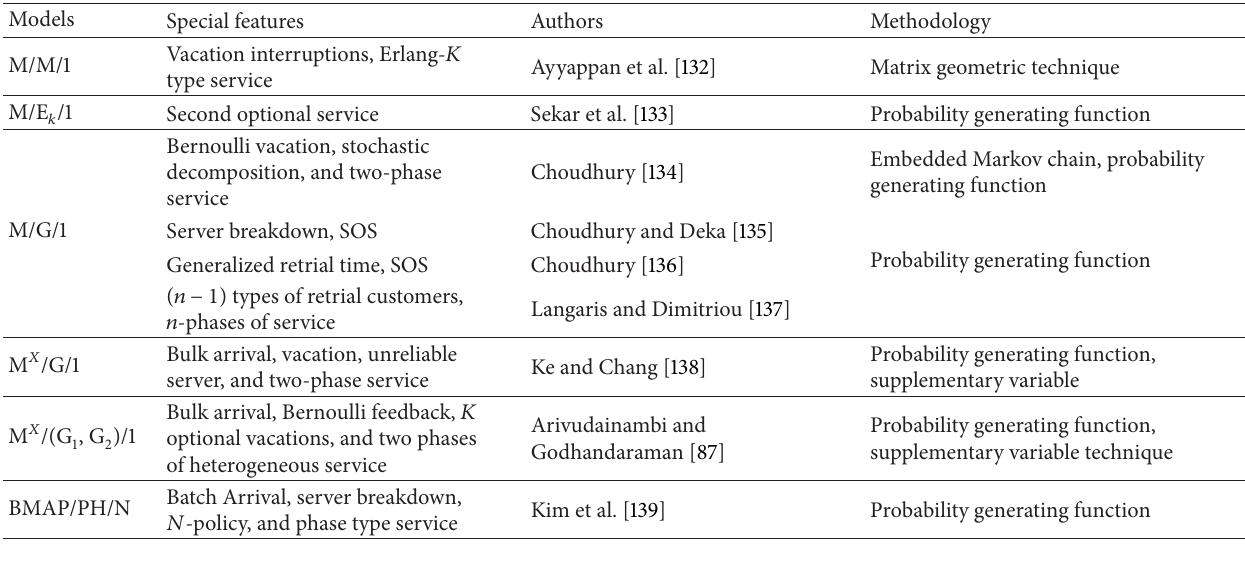
Table 2: Literature on retrial queue with phase service.